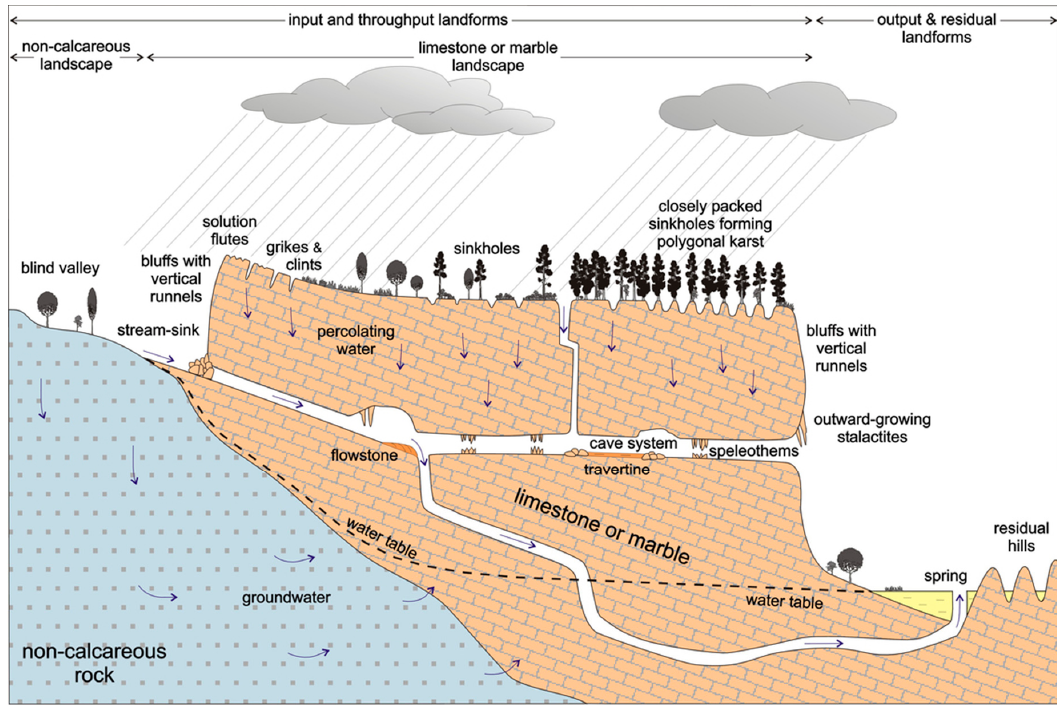
Figure 2. Karst topography dissolution pathways [7].